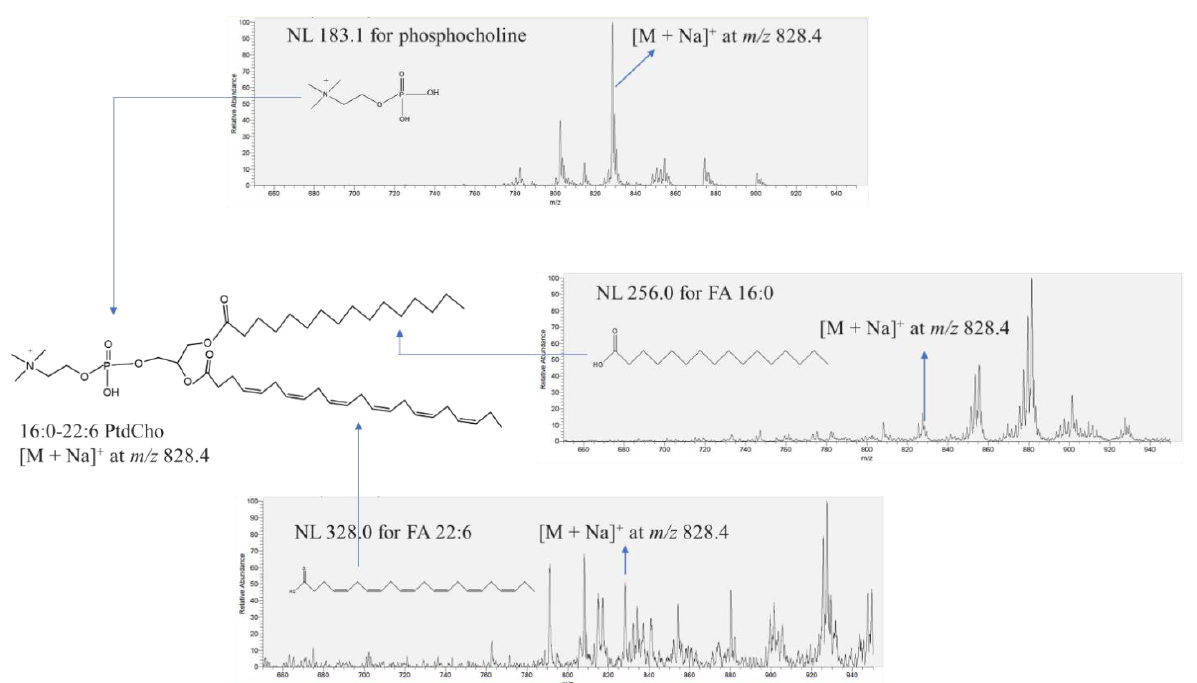
Figure 1. Identification of 16:0-22:6 PtdCho ([M + Na] + at m/z 828.4) in salmon muscle tissue by neutral loss (NL) scanning in the positive mode. NL 183.1, 256.0, and 328.0 provide information on the presence of phosphocholine, FA 16:0 (palmitic acid), and FA 22:6 (docosahexaenoic acid) moieties of the structure of 16:0-22:6 PtdCho, respectively.